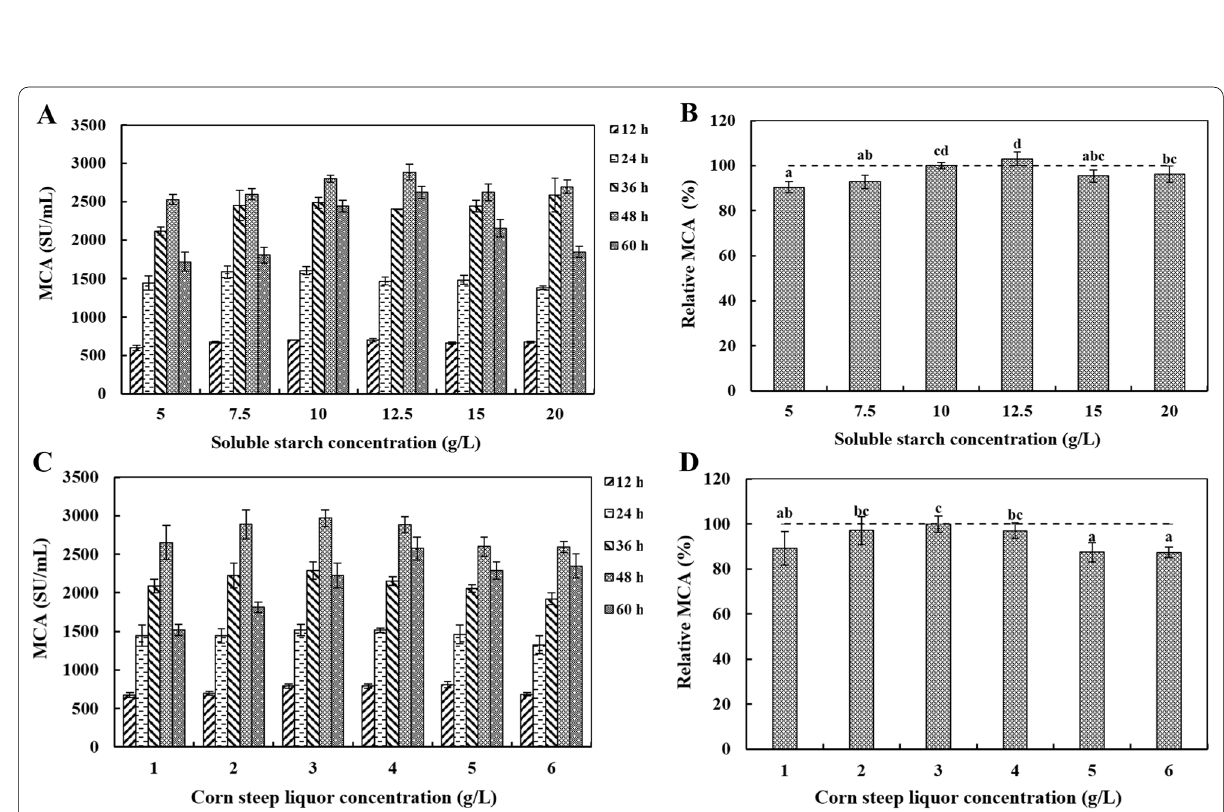
Fig. 6 The effects of different soluble starch (optimal carbon source) concentration ( A , B ) and corn steep liquor (optimal nitrogen source) concentration ( C , D ) on DB219 MCE production during fermentation (12–60 h). a − d Values in the same row with different superscripts are significantly different ( P < 0.05). Data were presented as means of triplicate measurements; Error bars were standard deviations. The data are represented as mean SD (n ± =